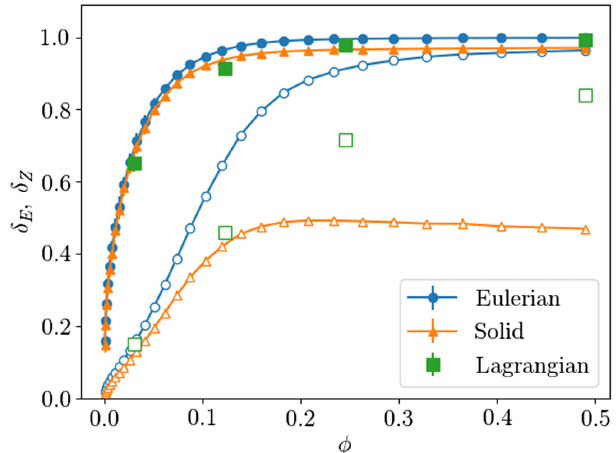
FIG. 6. Values of the velocity correlations δ E (filled symbols) and the vorticity correlations δ Z (empty symbols) as a function of the volume fraction ϕ for different nudging